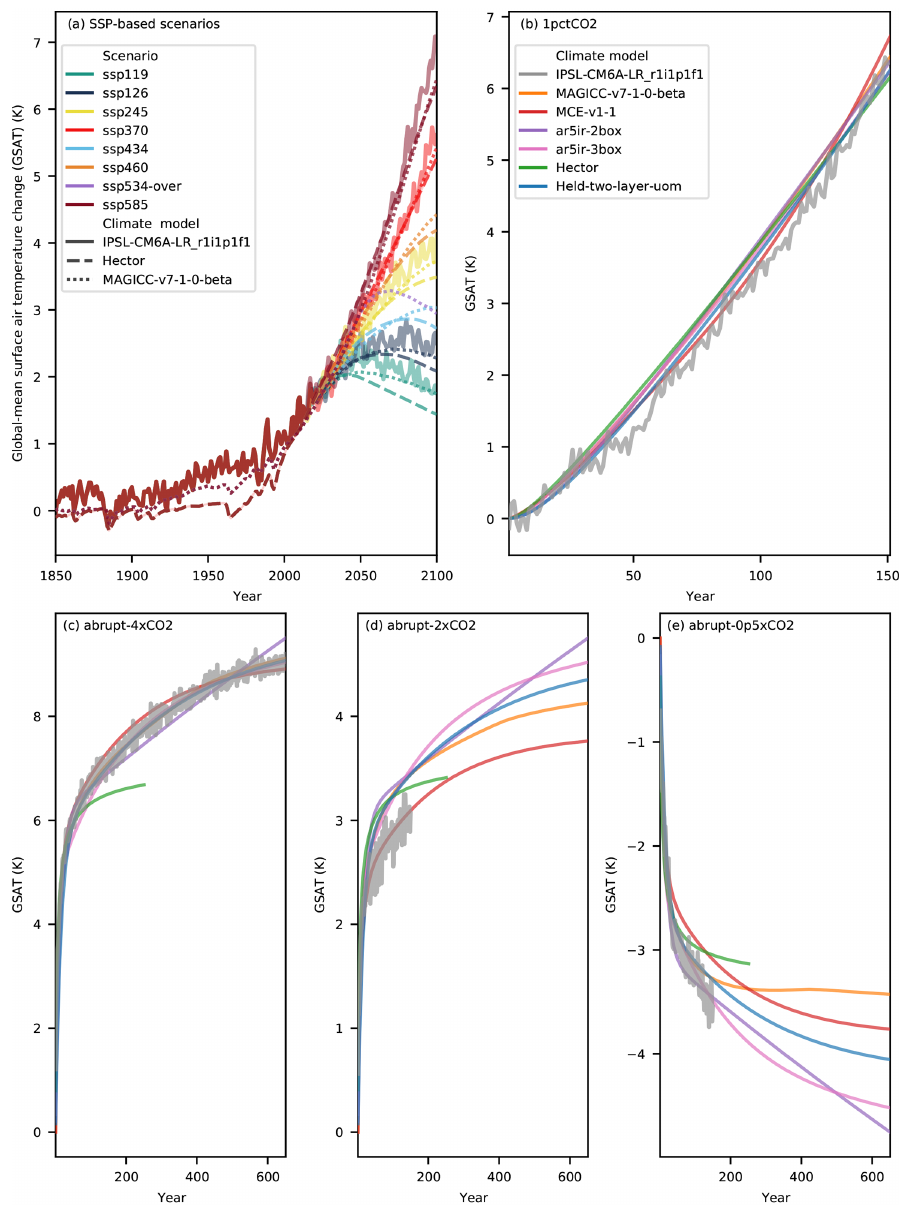
Figure 2. Emulation of CMIP6 models by RCMs. The thick transparent lines are the target CMIP6 model output (here from IPSL-CM6A-LR r1i1p1f1). The thin lines are emulations from different RCMs. Panel (a) shows results for scenario-based experiments, whilst panels (b) – (e) show results for idealised CO 2 -only experiments (note that panels b – e share the same legend). See the Supplement for other target CMIP6